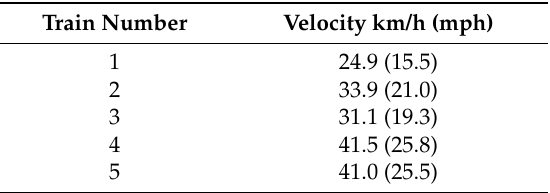
Table 3. Train crossing